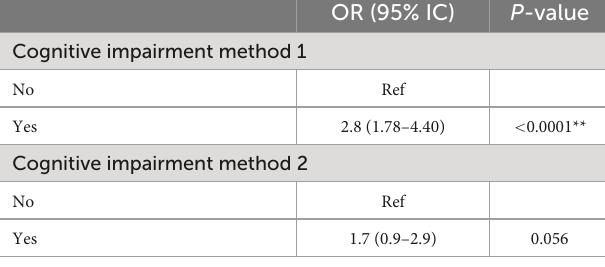
TABLE 3 Cognitive impairment of the participants comparing people without Type 2 Diabetes Mellitus and participants with Type 2 Diabetes